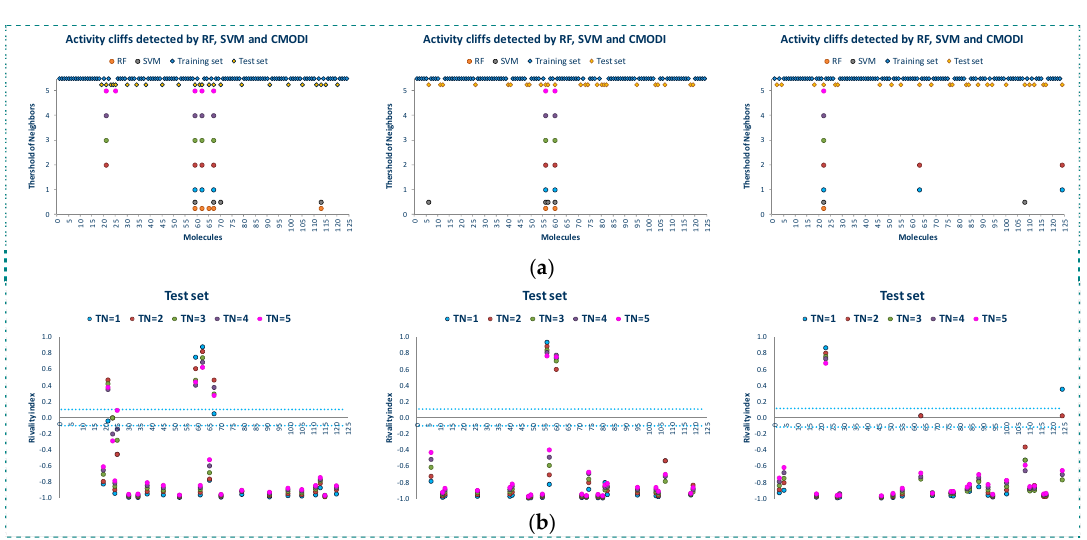
Figure 6. False positive/negative detected by RF and SVM algorithms and CMODI in the three external validations ( a ), rivality index values of the molecules of the external sets in the three external validations ( b ).